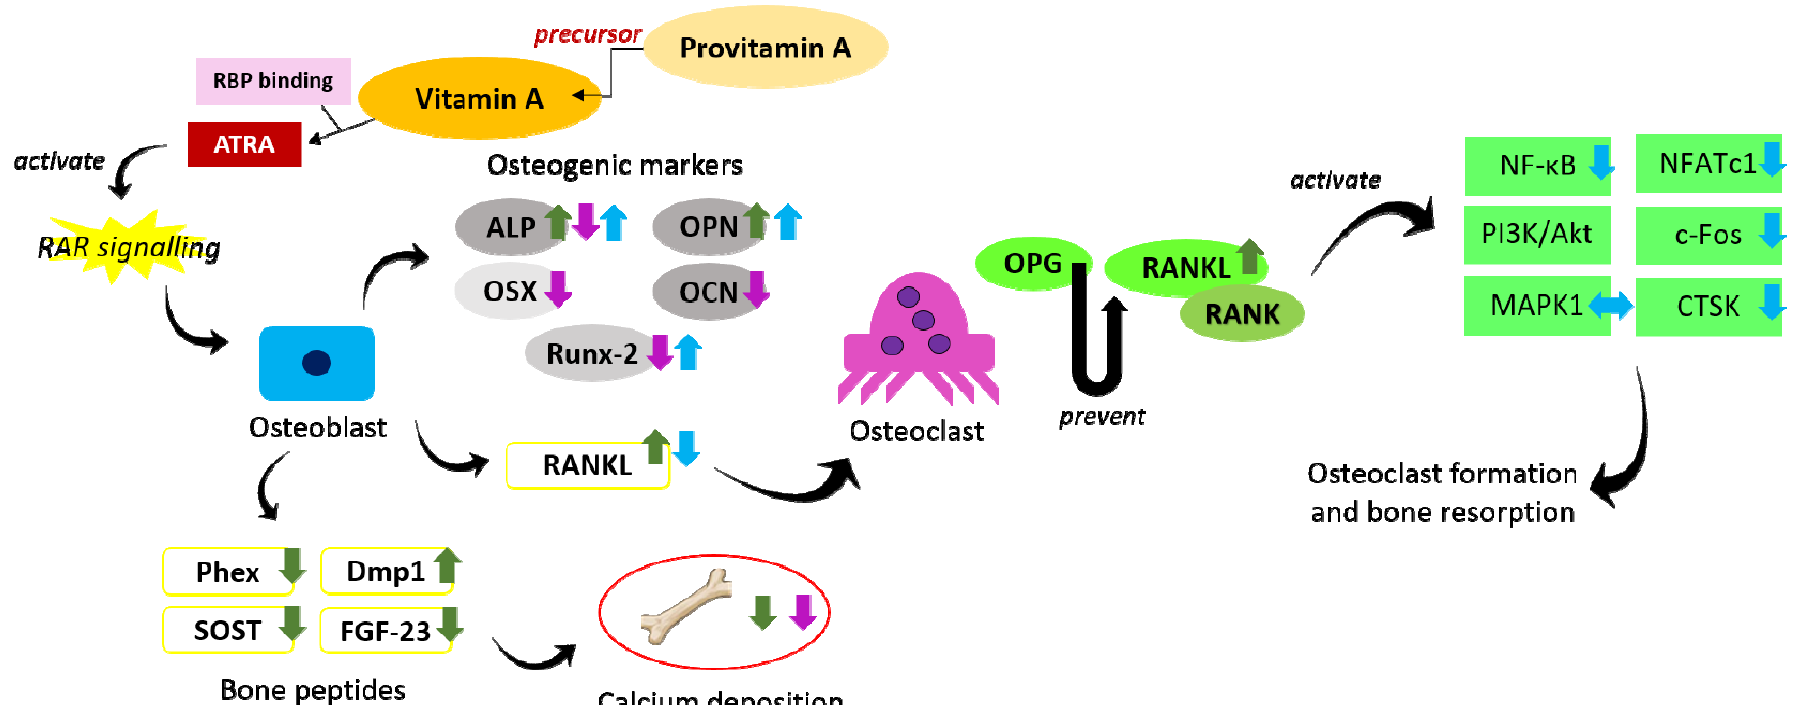
Figure 1. The effects of vitamin A and provitamin A on the regulation of osteogenesis and osteoclastogenesis. Provitamin A serves as the precursor for vitamin A, which is then converted to ATRA in target cells to act as ligand for RAR and perform their functions. Vitamin A at low concentration promotes osteoblastic activity but inhibits bone mineralisation (indicated by green arrows). Vitamin A at high concentration inhibits both bone differentiation and bone mineralisation (indicated by purple arrows). Provitamin A promotes osteoblast differentiation and inhibits osteoclastic activity (indicated by blue arrows). The arrow pointing upward indicates an increase, the arrow pointing downward indicates a decrease, and the two-headed arrow indicates no change. Abbreviations: Akt = protein kinase B; ALP = alkaline phosphatase; ATRA = all-trans-retinoic acid; c-Fos = Fos proto oncogene; CTSK = cathepsin K; Dmp1 = dentin matrix protein 1; FGF-23 = fibroblast growth factor-23; MAPK = mitogen-activated protein kinase; NFATc1 = nuclear factor of activated T-cells cytoplasmic 1; NF- κ B = nuclear factor-kappa B; OCN = osteocalcin; OPG = osteoprotegerin; OPN = osteopontin; OSX = osterix; PI3K = phosphatidylinositol 3-kinase; Phex = phosphate regulating endopeptidase homolog X-linked; RANK = receptor activator of nuclear factor kappa-B; RANKL = receptor activator of nuclear factor-kappa B ligand; RAR = retinoic acid receptor; RBP = retinol-binding protein; Runx-2 = runt-related transcription factor 2; SOST = sclerostin.